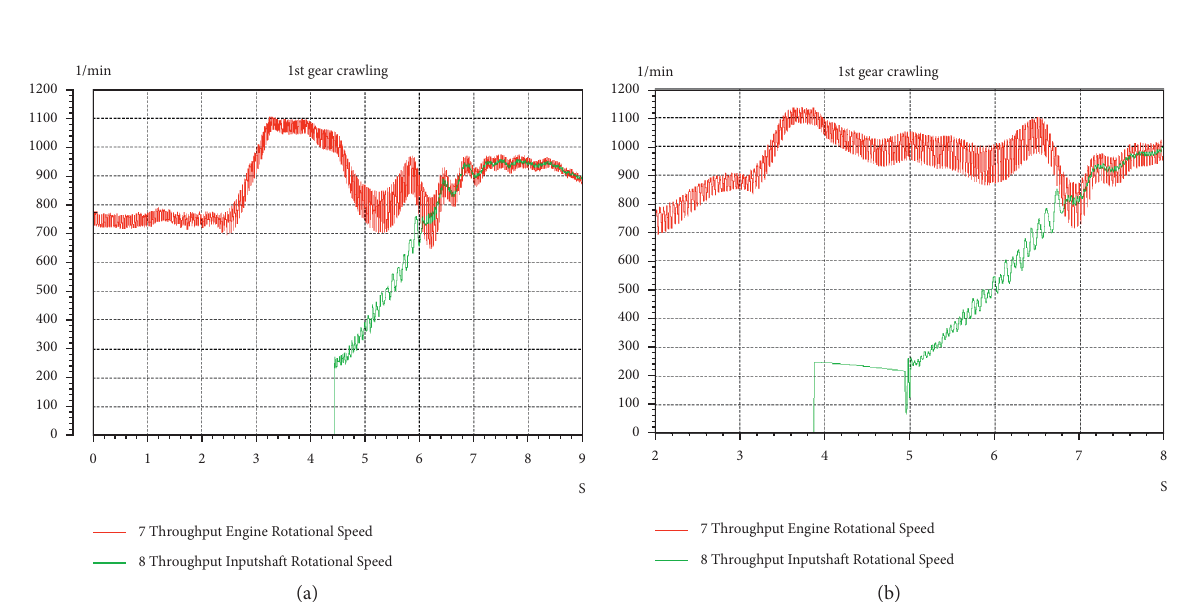
Figure 12: Starting condition. (a) 1st gear start. (b) 1st gear loaded